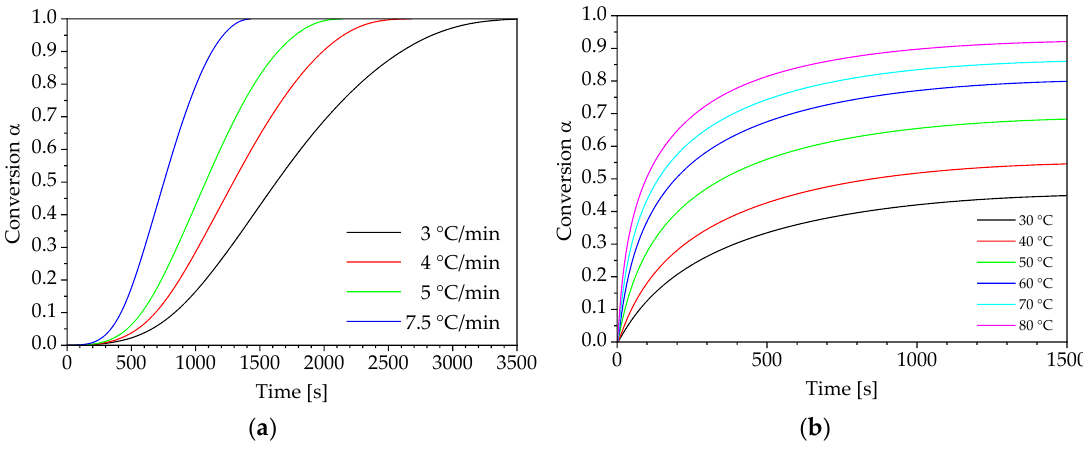
Figure 4. Progress of conversion: ( a ) non-isothermal curing and ( b ) isothermal conditions curing.